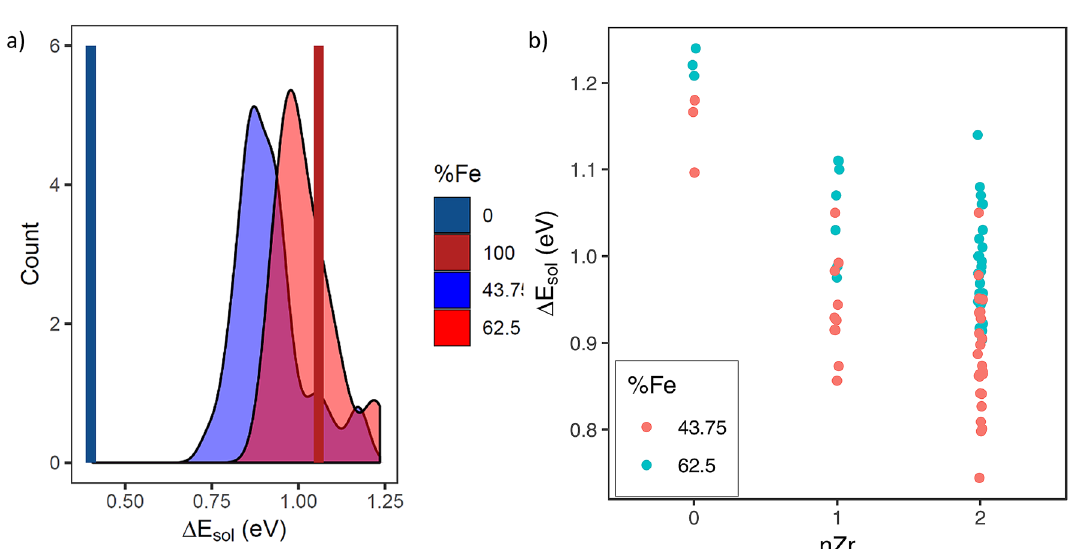
Figure 4. ( a ) Enthalpy difference for H solution in ternary SPPs (as depicted by the two broad peaks), ZrCr 2 (blue line) and ZrFe 2 (red line) when compared to H solution in hcp-Zr. ( b ) Relative enthalpy of solution of H in SPPs (compared to hcp-Zr) as a function of number of Zr nearest neighbour atoms